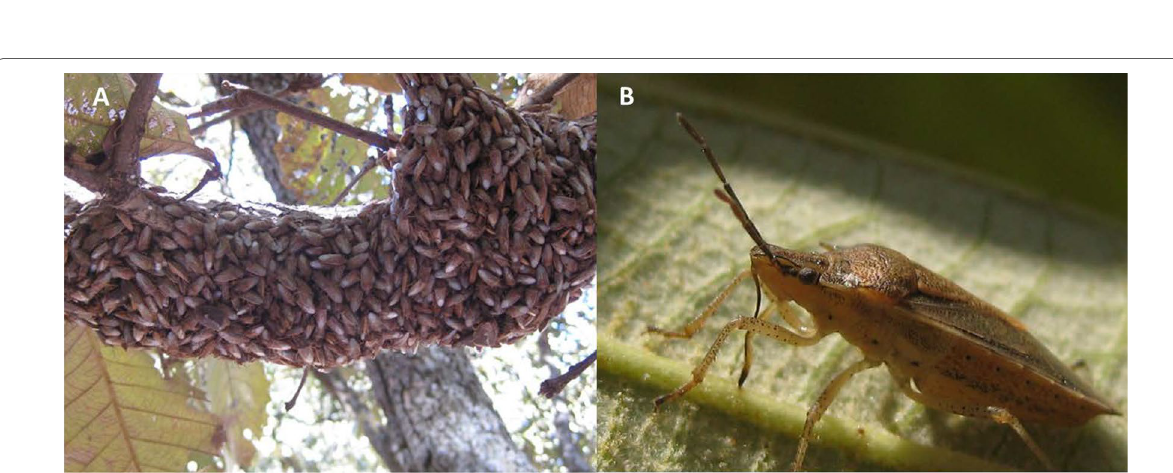
A wide diversity of EPF associated with arthropods at the overwintering sites was recorded, with the greatest prevalence of O. mexicana . The genera Beauveria , Isaria , Hirsutella, Metarhizium, and Cordyceps were recorded in that order of frequency (Fig. 3). Sporulation of the latter 3 was recorded in the field only under the highest humid- ity levels (i.e. during the rain season) or under laboratory conditions. In the genus Lecanicillium, only one individ- ual was incubated in the laboratory. A trend of lower mortality of O. mexicana (with and without mycosis) was observed at the site of 2219 masl, compared to 2351 masl. The mortality of this sampling level was similar and on some dates higher (80.2%) than